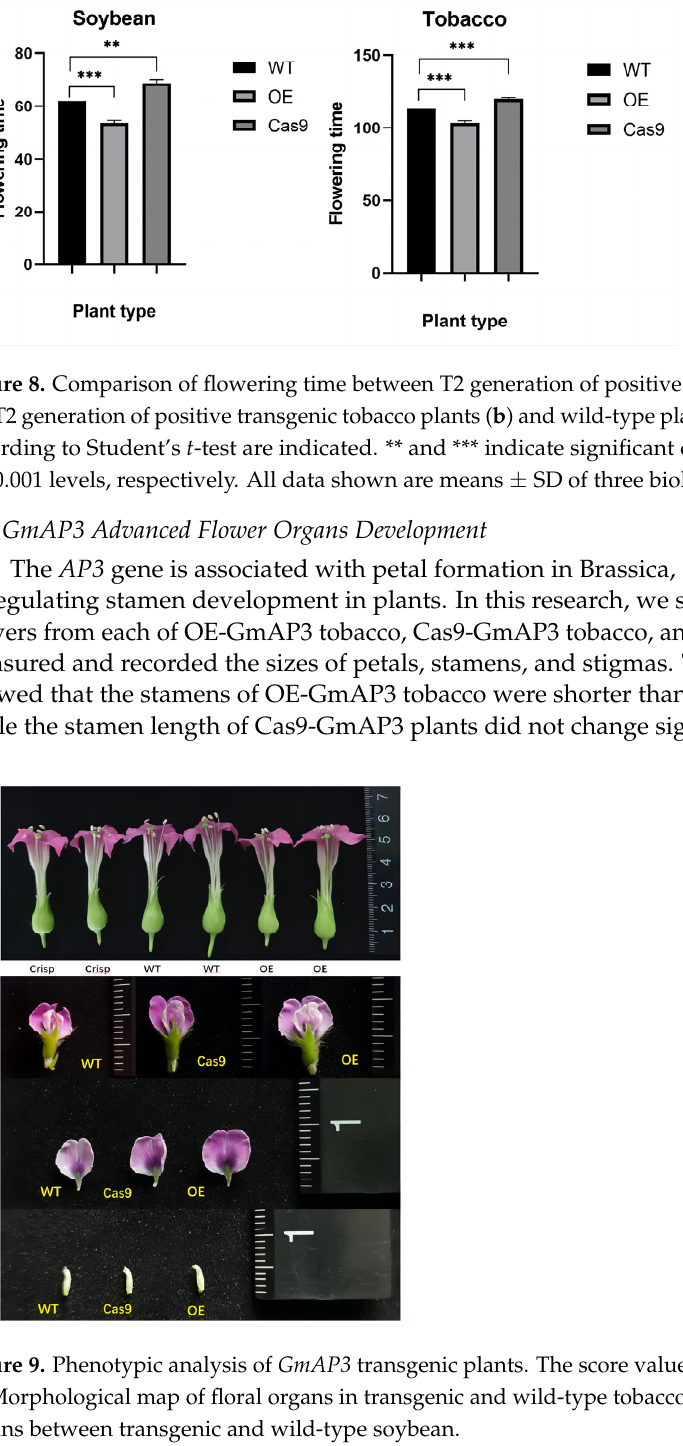
7 of 15 Figure 7. Interactions between GmAP3 and AP1 in yeast. M:DGL2000 DNA, 1~5: sample. ( a ) pGBKT7-GmAP3 vector; ( b ) pGADT7-AP1 vector; ( c ) SD-leu-Trp culture medium; ( d ) SD-Leu-His- Ade-Trp culture medium.